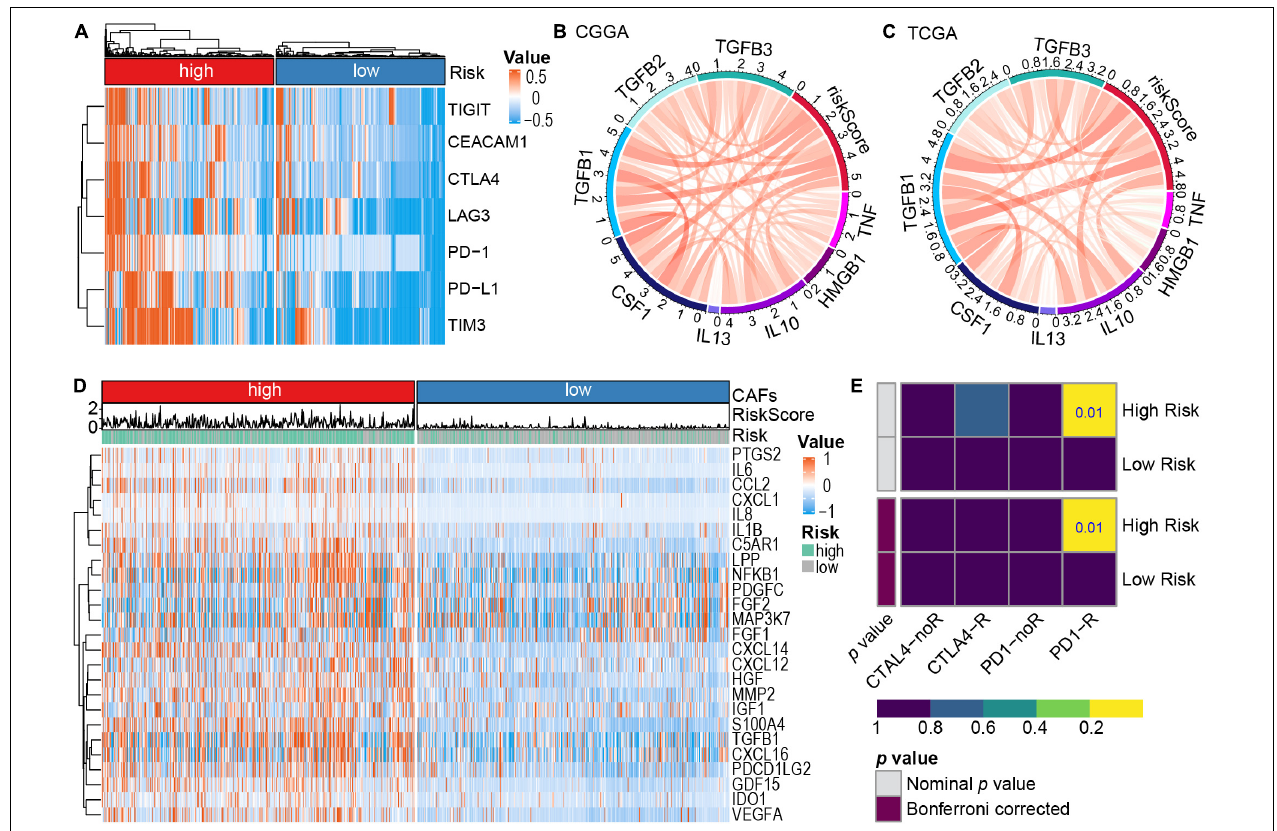
FIGURE 7 | The role of risk signature in immune microenvironment and immunotherapy. (A) Expression of immune cell exhaustion marker genes in the high- and low-risk subtypes. (B,C) Correlation between representative macrophage chemokines and risk score, CGGA dataset (B) , TCGA dataset (C) . M1